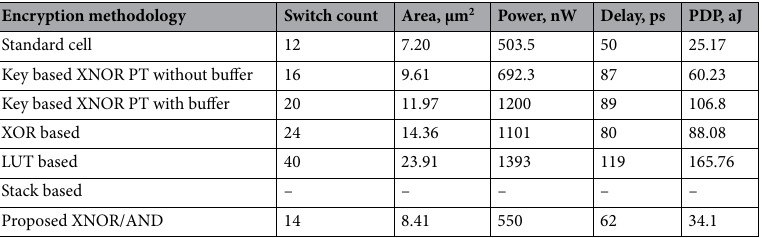
Table 16. Results comparison for XNOR